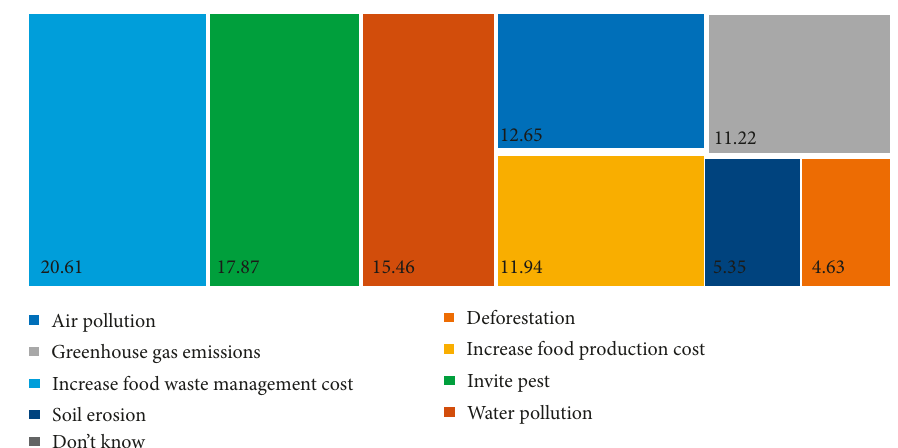
Figure 9: Perception of food waste